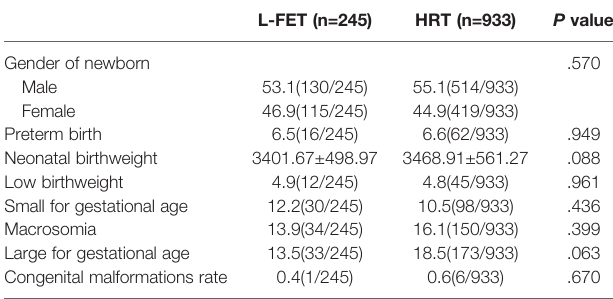
TABLE 3 | Comparison of singleton neonatal outcome between the two groups. L-FET (n=245) HRT (n=933) P value Gender of newborn .570 Male